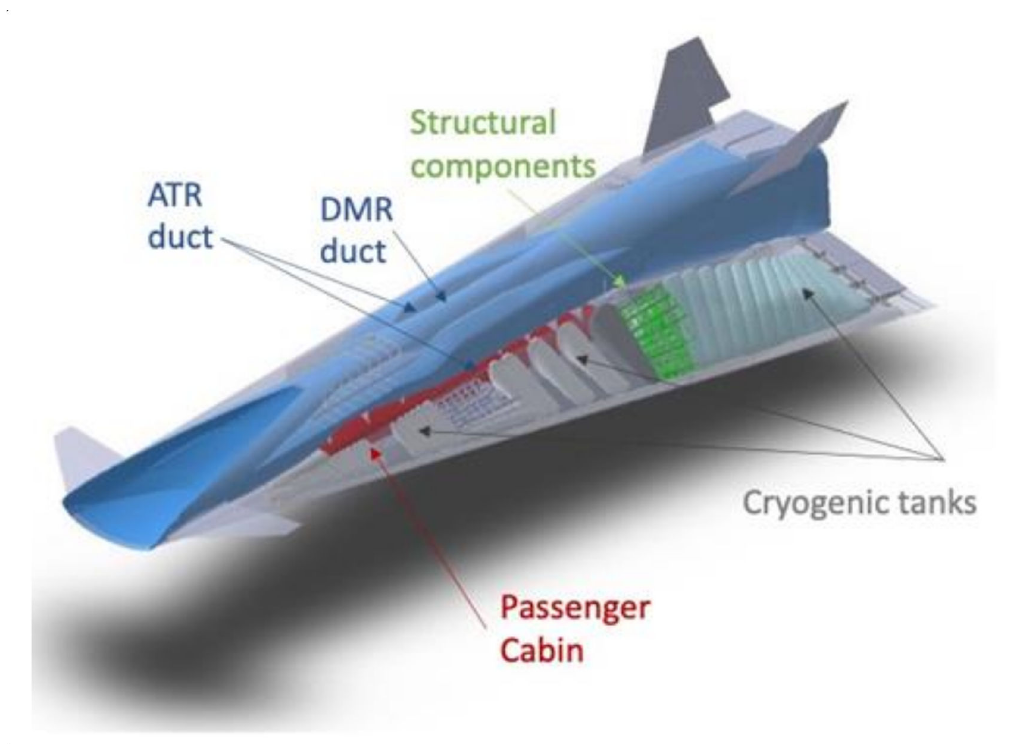
Figure 1. STRATOFLY MR3 vehicle with indication of main